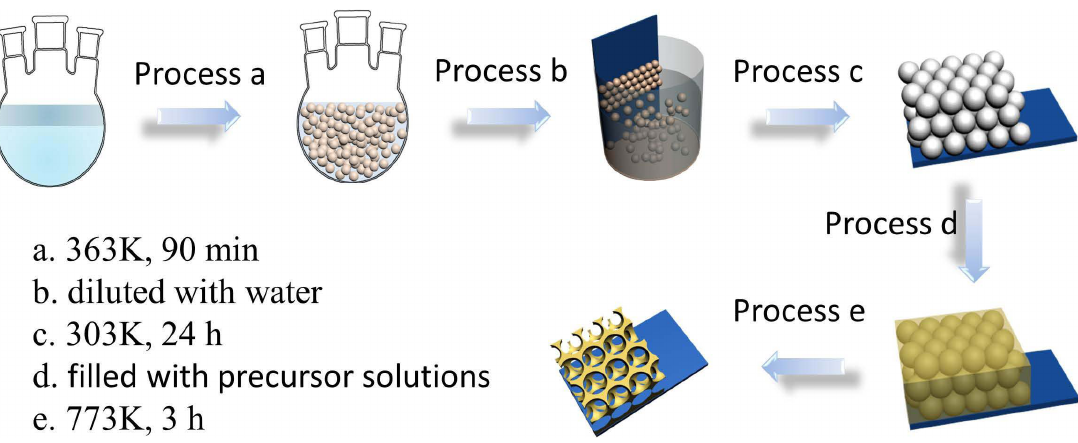
Figure 1. Schematic view of the process to fabricate the 3DIO WO 3